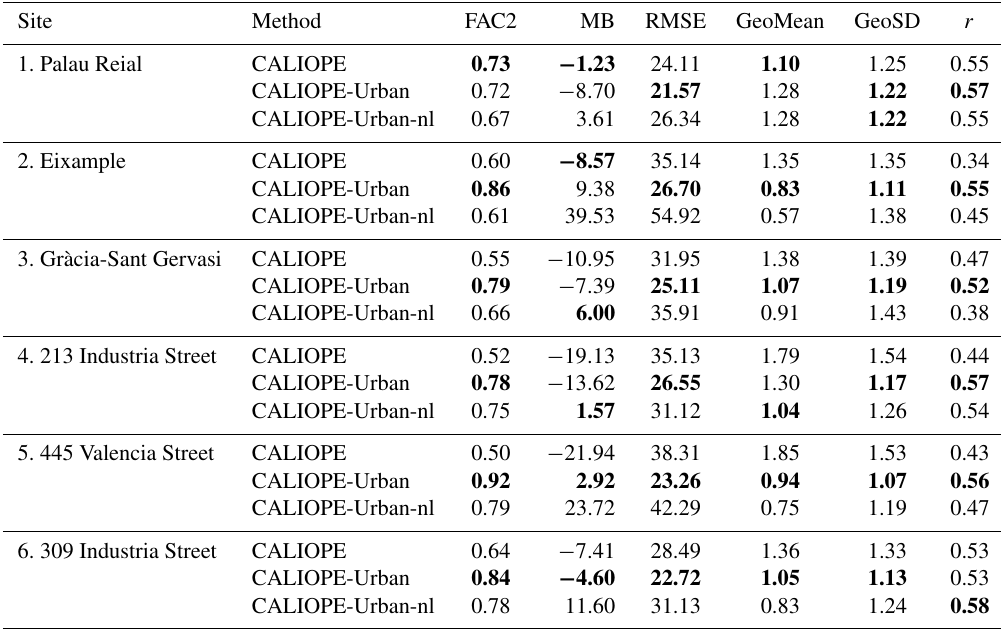
Table 4. NO 2 model evaluation statistics calculated at six sites (described in Sect. 3) for hourly concentrations during April and May 2013 for CALIOPE, CALIOPE-Urban and CALIOPE-Urban without local developments (CALIOPE-Urban-nl). Bold numbers represent model results with better performance for each statistic and